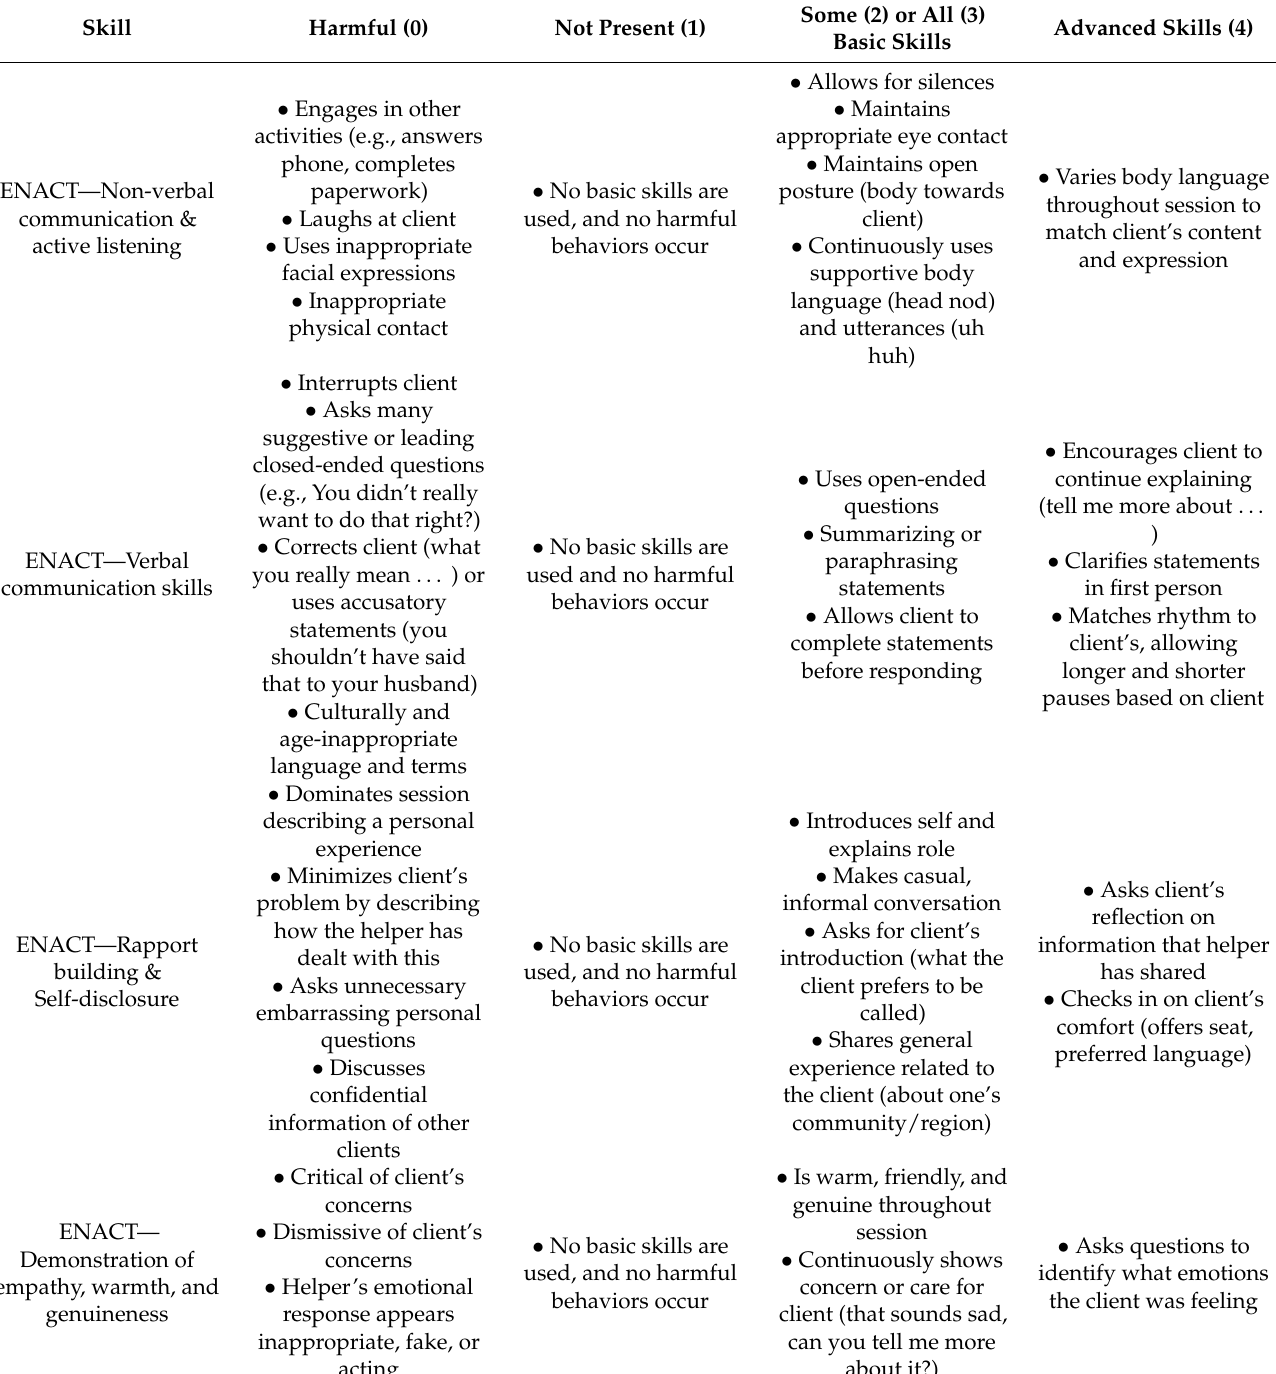
Table 1. Roleplay